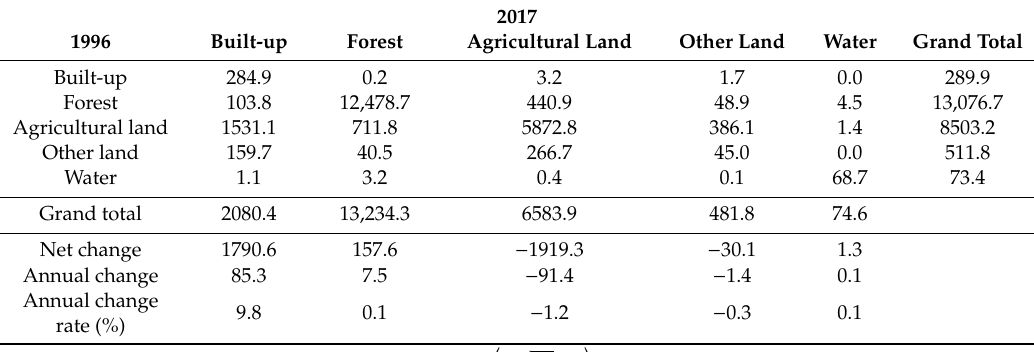
Table 8. Land use and land cover change matrix (h),